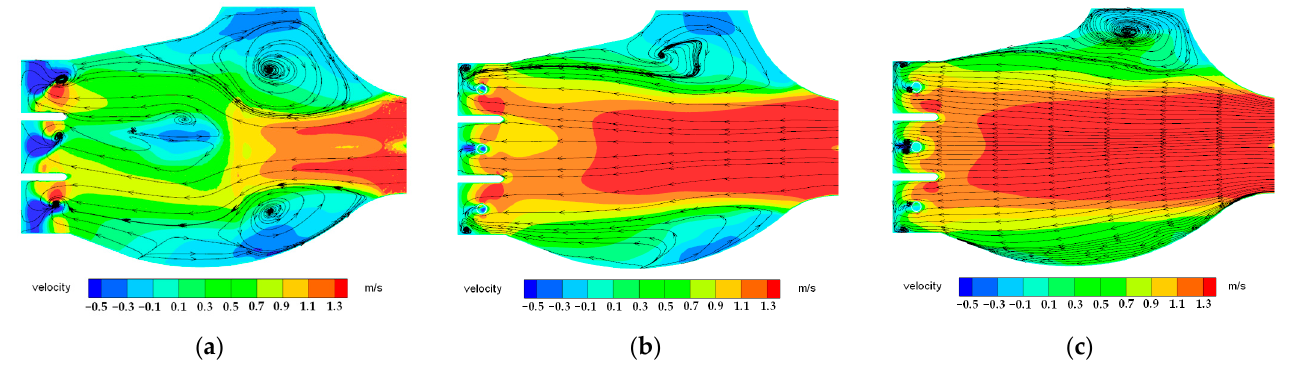
Figure 10. Flow diagram of the bottom layer ( a ), middle layer ( b ), and surface layer ( c ) in scheme 0.